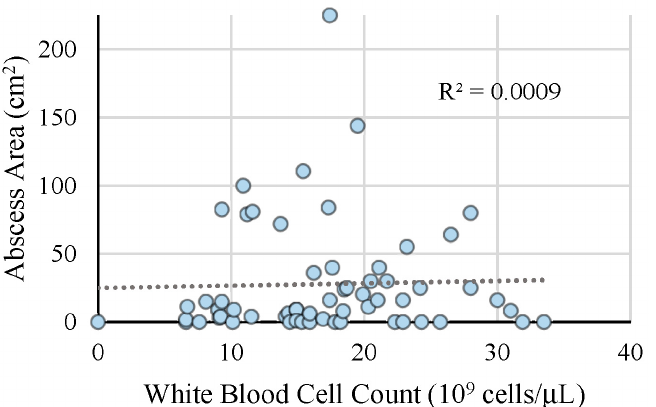
Table 2. Diagnostic factors associated with operative incision and drainage.